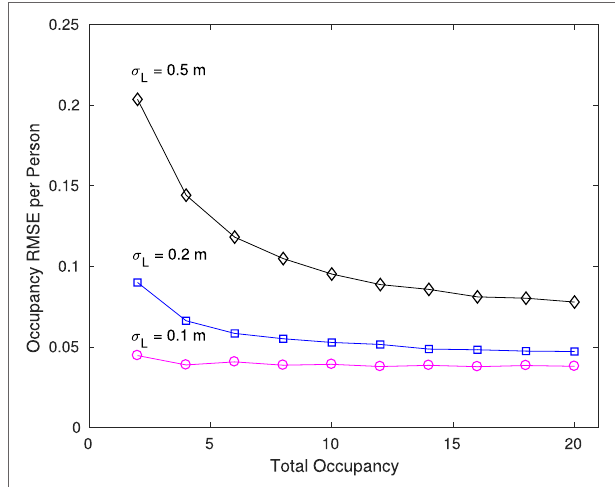
FIGURE 12 | Occupancy estimation RMSE per person as a function of increasing numbers of occupants on a proportionally sized floor plan and monitored region as explained in Section 3.3. This normalized occupancy error is shown for several levels of localization error, (cid:27) L